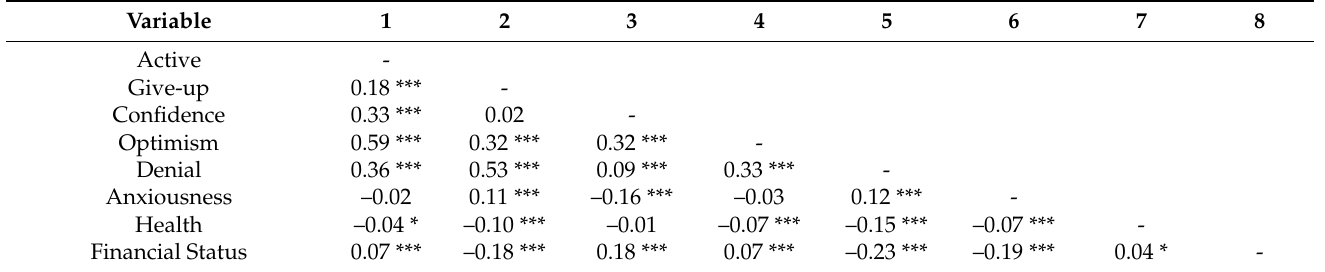
Table 2. Correlation Matrix of Variables of Interest.